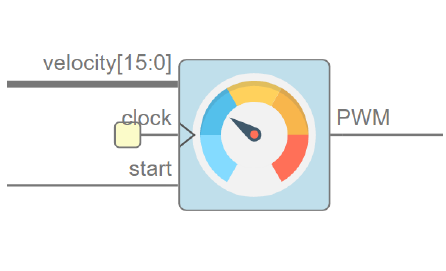
Figure 13. Appearance of PWM module in IceStudio.